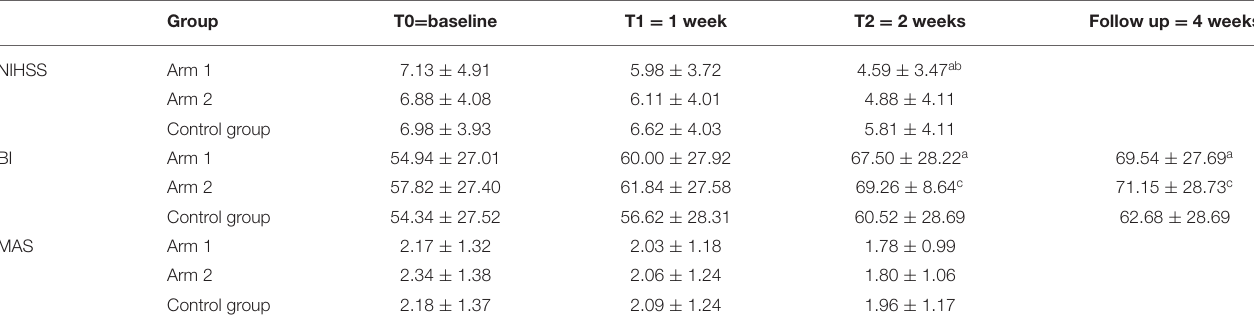
TABLE 3 | Scores and changes for the National Institutes of Health Stroke Scale (NIHSS), the Barthel Index (BI), and the Modified Ashworth Scale (MAS) in the three study arms (x ±